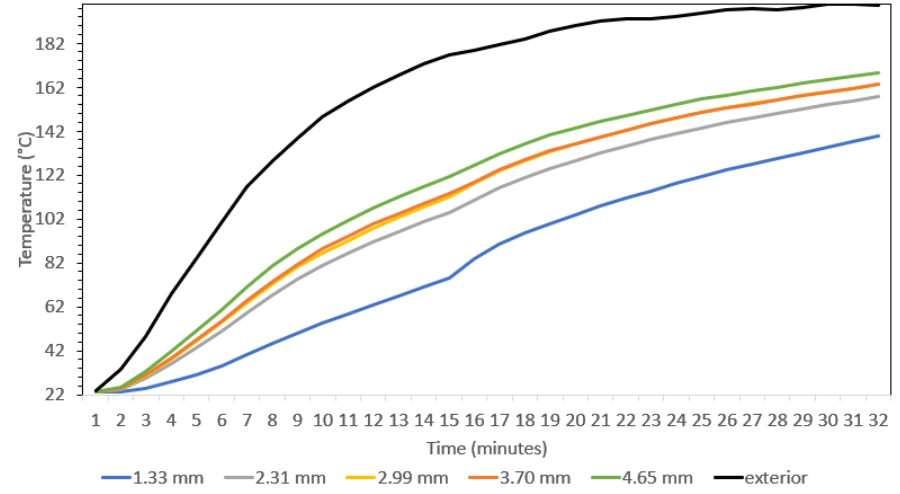
Figure 9. Thermal transient in-situ temperature distribution results.